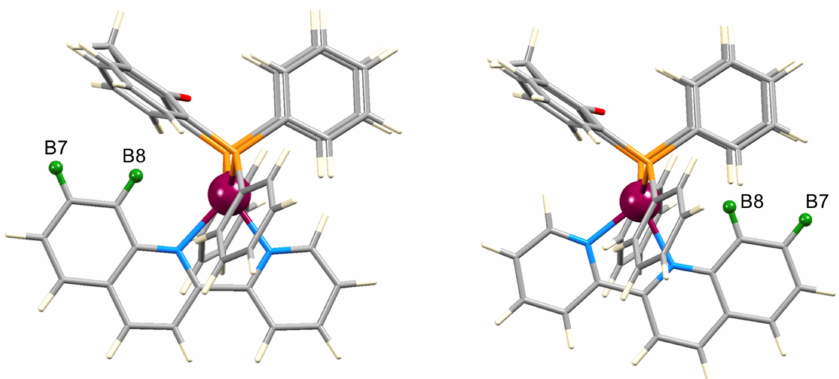
Figure 4. Modelled (Molecular Mechanics using Spartan '18 (v. 1.3) [28]) of two possible conformers of [Cu(xantphos)( 1 )] + illustrating the di ff erent environments of quinoline protons H B7 and H B8 in the two conformers.